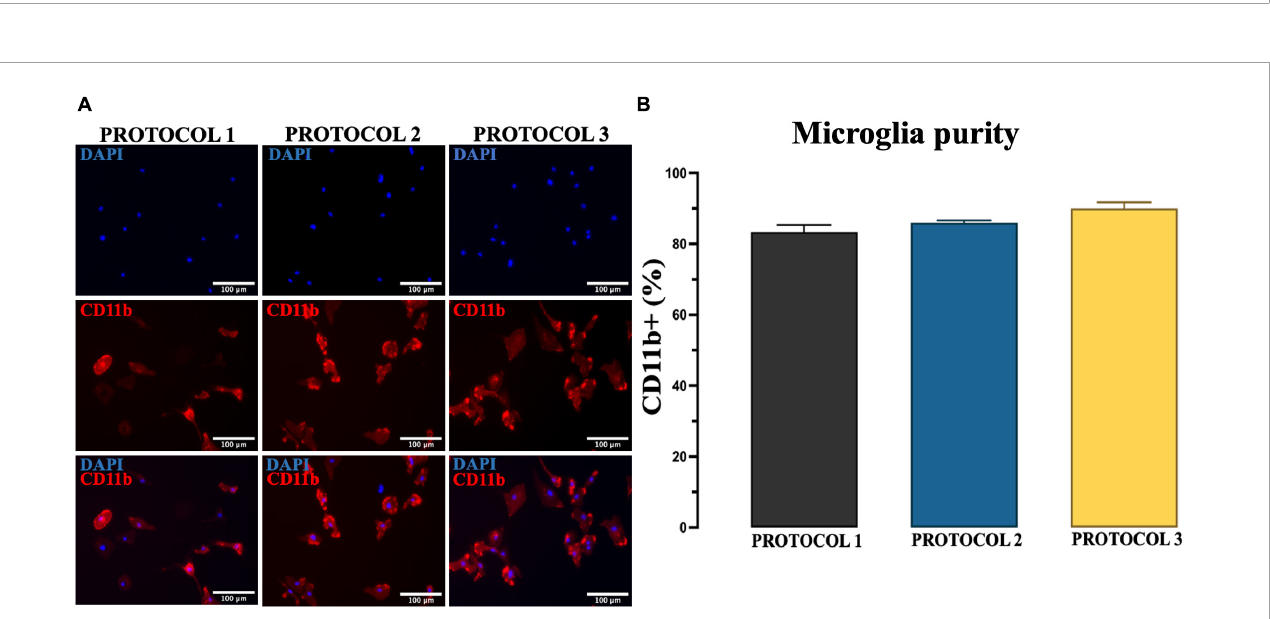
FIGURE4 Evaluation of the purity of microglia. (A) Purity of cultures established by PROTOCOL 1, PROTOCOL 2, and PROTOCOL 3 was determined via immunocytochemistry using a specific marker for microglia (CD11b, red) and nuclear dye (DAPI, blue). Scale bar: 100 µ m. (B) Graphical representation of the percentage of CD11b + cells at day 7 after isolation. Data are presented as mean ± SEM; N =